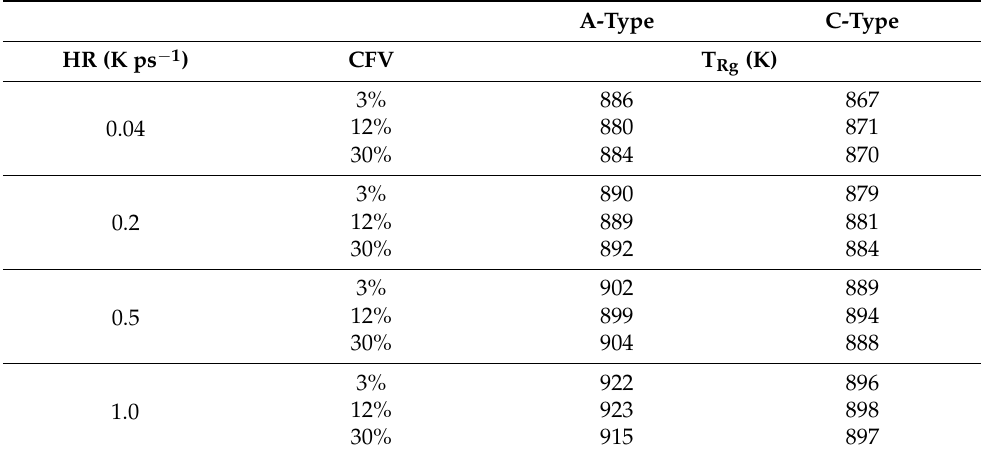
Table 2. Corresponding temperature at 10% expansion threshold in z -direction (T Rg ) for both types with 3%, 12%, and 30% core volume fraction (CVF) NPs under 0.04, 0.2, 0.5, and 1.0 K ps − 1 heating rate (HR) melting